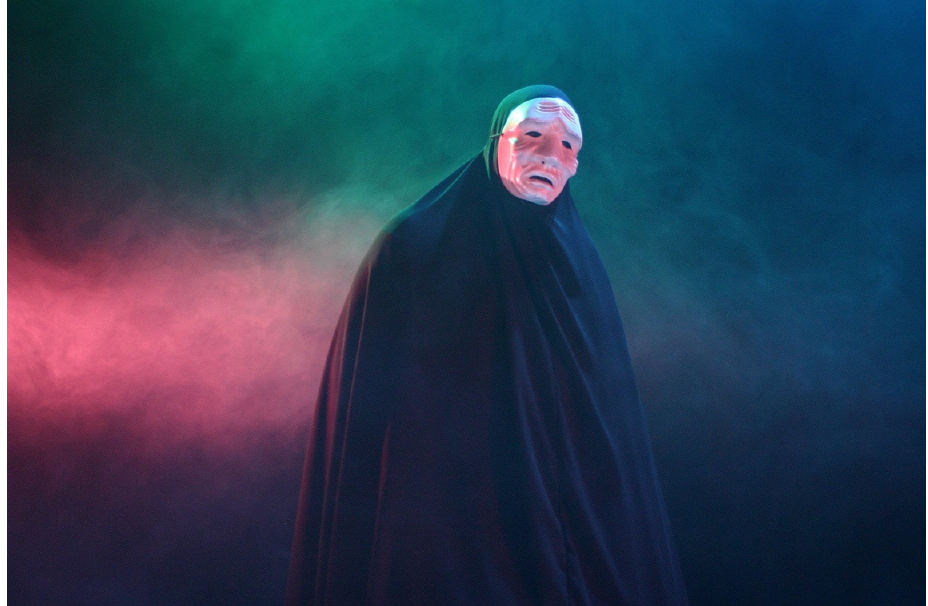
Figure 4. The moving statue of the ghost in El-Basha’s production. Photo: Akram Safadi. Courtesy of Kamel El-Basha and the Al-Hakawati Palestinian National Theatre.